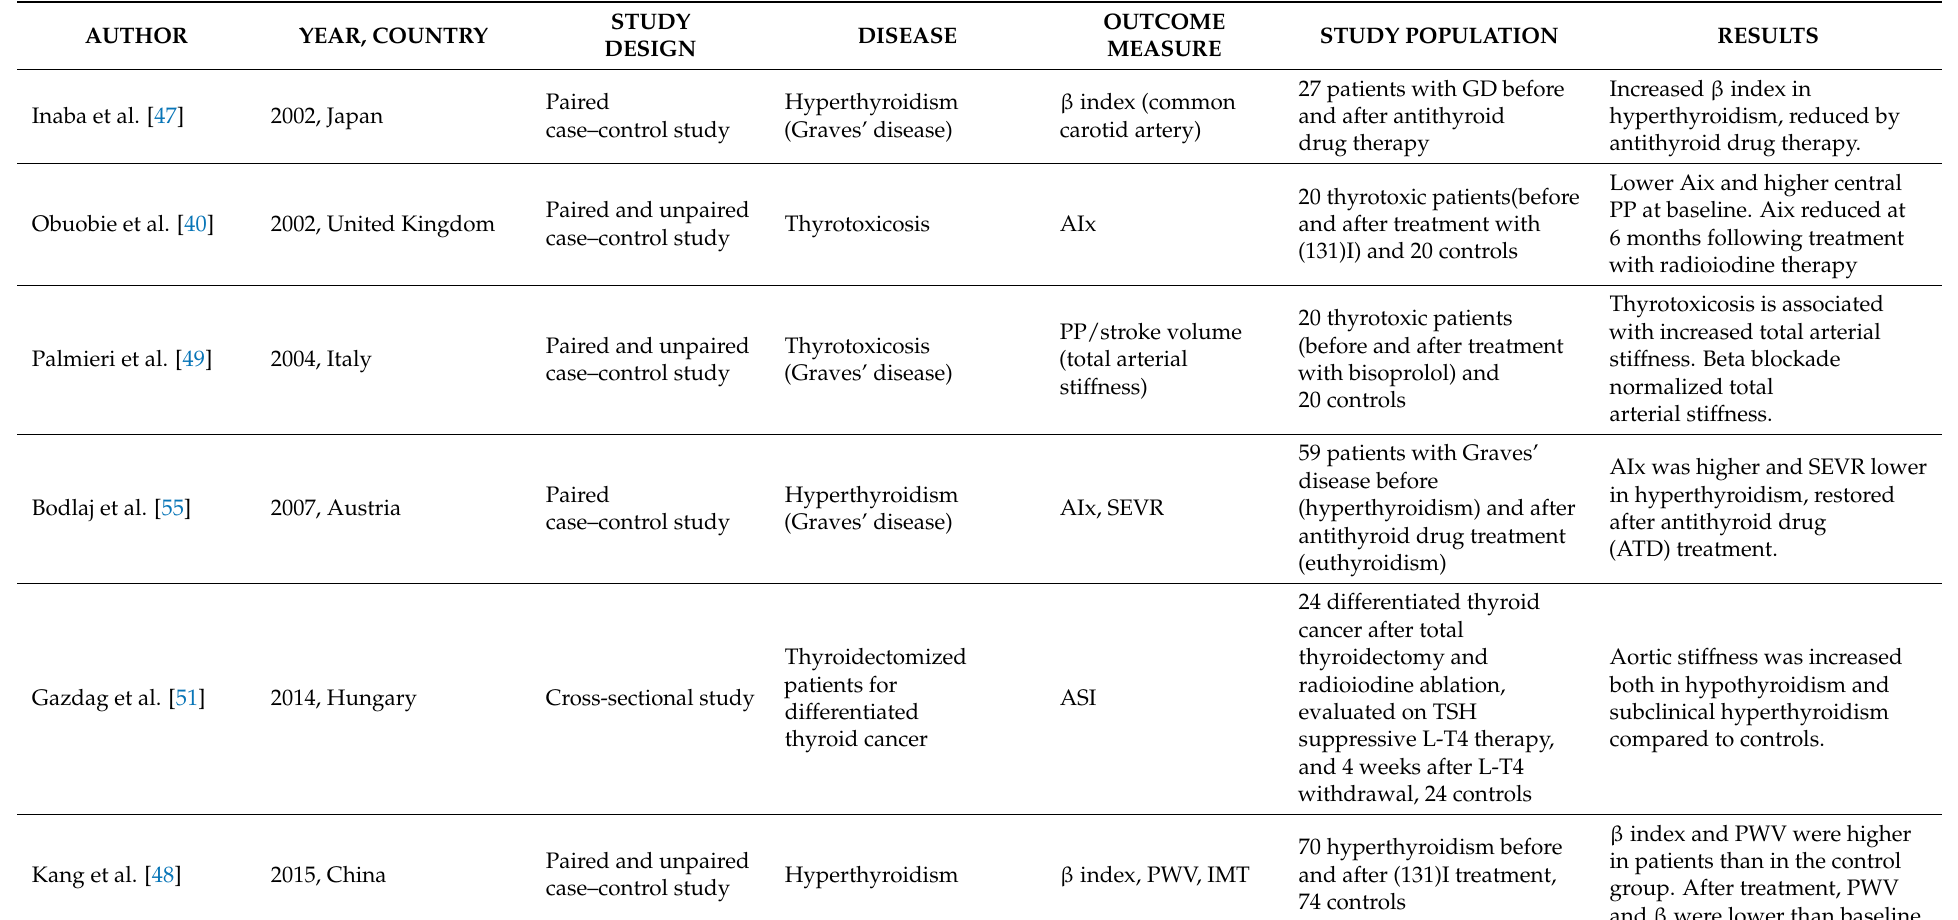
Table 2. Experimental studies evaluating arterial stiffness and